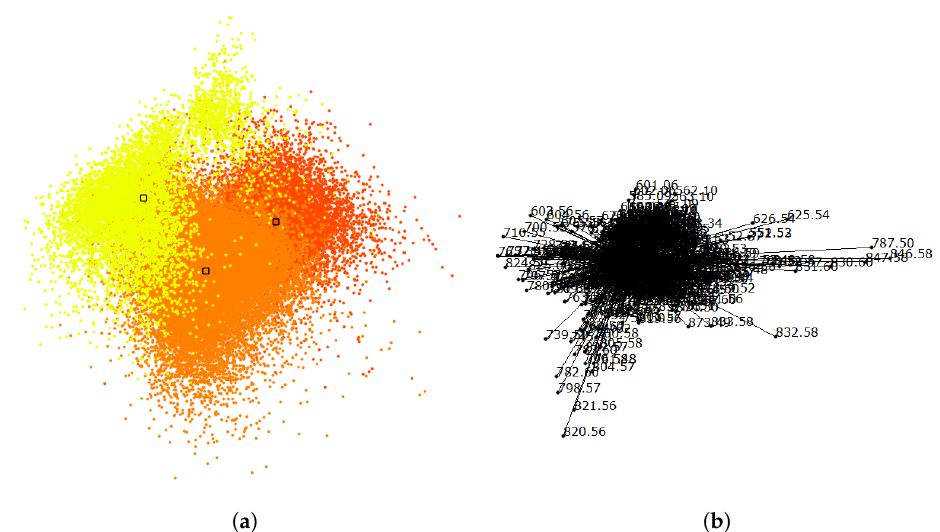
Figure 17. Rat testis data set [9]: ( a ) Linear embedding of labeled data, where color-coded labels correspond to interactively generated clusters and respective regions in Figure 16. ( b ) Corresponding SC configuration.